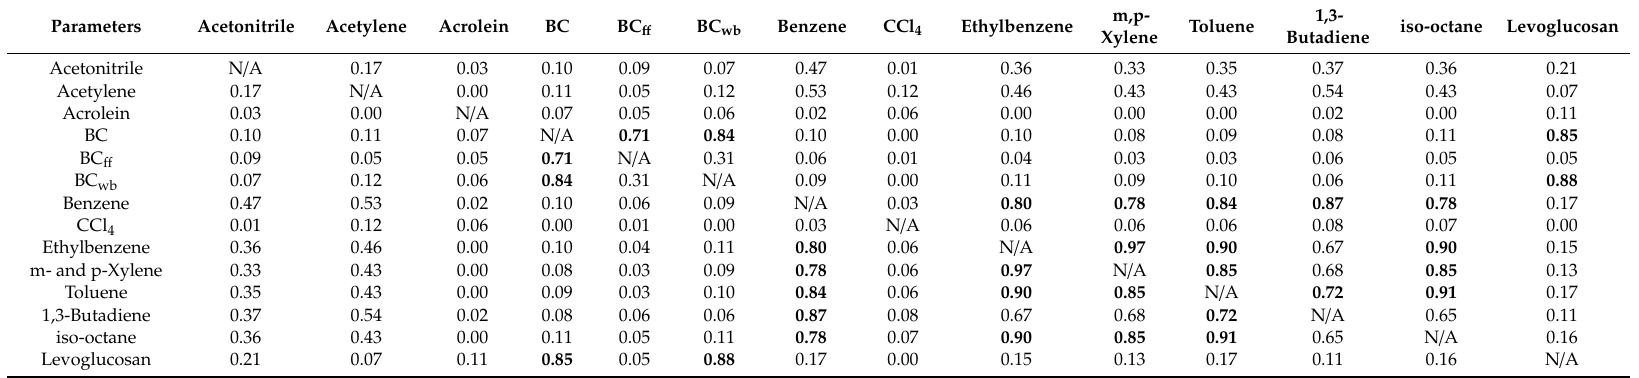
Table 5. Matrix of median correlation coe ffi cient ( R 2 ) of HAPs, PM, and filter measurements (where available) across all six monitoring sites. Correlations greater than 0.70 are shown in